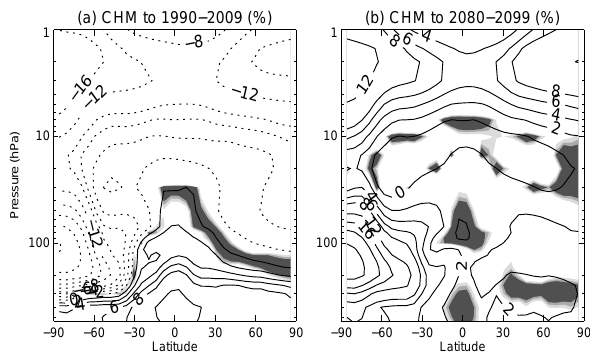
Fig. 5. The net change in the ozone mixing ratio from the CHM experiment from 1960–1974 to 1990–2009 (a) and from 1990–2009 to 2080–2099 (b) . As in Fig. 2, the change is expressed as a percentage of the 1960–1974 average and can be directly compared to the results of the REF-B2 and GHG run shown in Fig. 2. Fig. 6. Time series of the concentrations of O 3 (a) , total reactive nitrogen, NO y (b) , and N 2 O (c) from the REF-B2 (black line), GHG (red line) and CHM (green line) experiments. The concentrations are ensemble averages from 60 ◦ S to 60 ◦ N at 10hPa and have been deseasonalized by fitting an 8 term sinusoidal to the monthly averages and smoothed with a Gaussian filter with a width of four years. The first panel also includes the estimate of the ODS effect on ozone derived as (REF-B2–GHG), with the addition of the 1960–1974 average from the REF-B2 experiment (green dashed line). tion of ozone in the REF-B2 run at 10 hPa returns to 1980 values around 2020, though halogens do not decrease